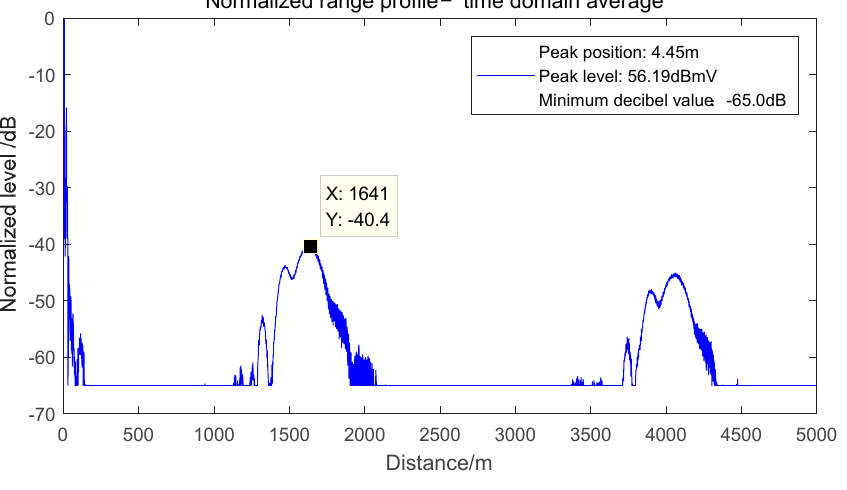
Figure 4. Position of false alarm signal under Δ f j 1 = 0 MHz and Δ f j 2 = 40 MHz electromagnetic inter-ference.